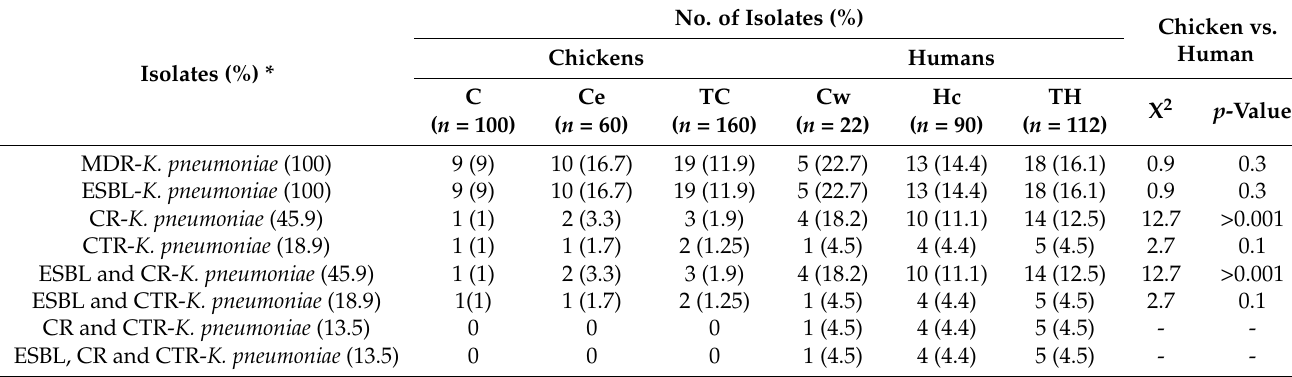
Table 1. Frequency distribution of 37 multidrug-resistant K. pneumoniae isolates recovered from broiler farms and human cases in the study area.